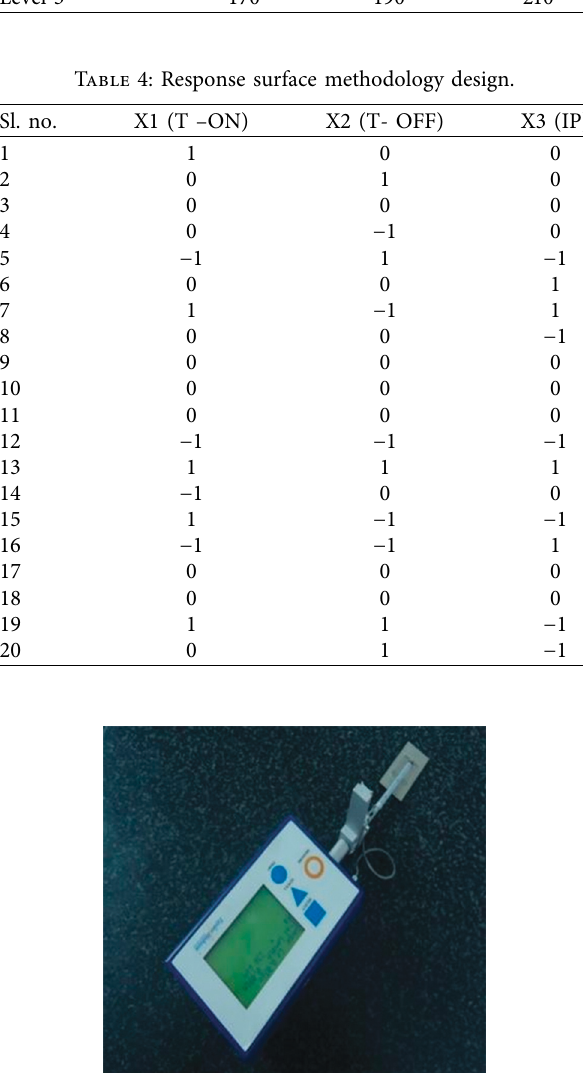
Figure 3: Roughness tester.